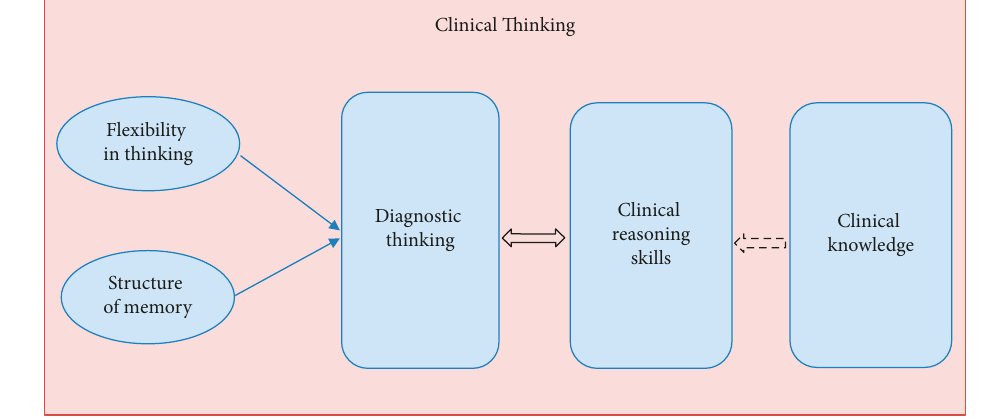
Figure 1: Conceptual framework of the study.